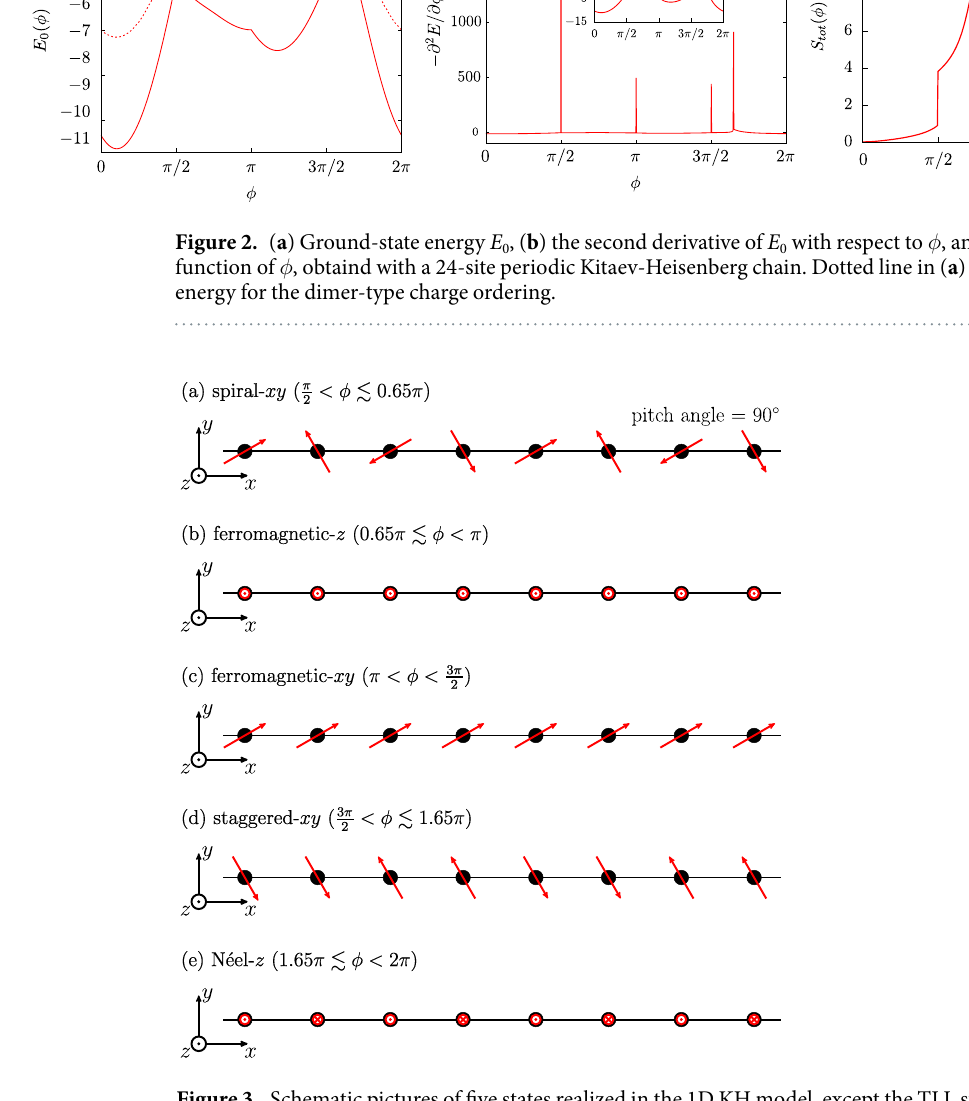
Figure 3. Schematic pictures of five states realized in the 1D KH model, except the TLL state at φ < < π 0 the phases ( a , c , d ), the spins lie mostly on the xy-plane and these states are rotational invariant around the z -axis. In phases ( b , e ), the spins almost align along the z -direction and a state having opposite spin directions is